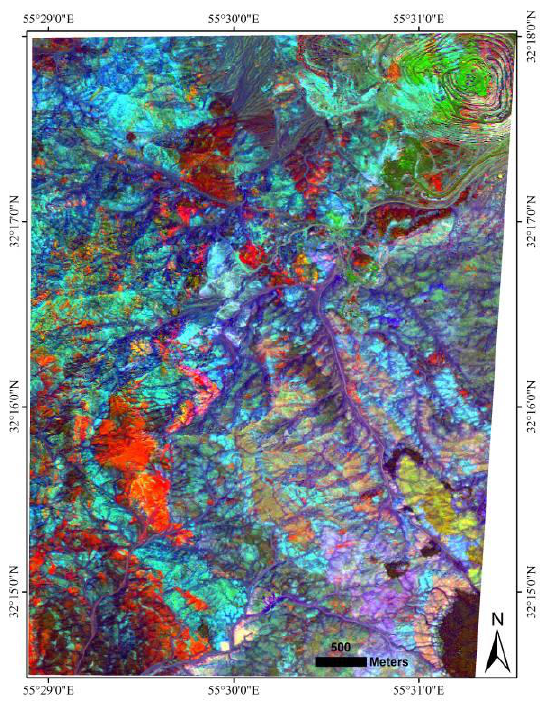
Fig. 6. WV-3 False-color composite 2 m spatial resolution band ratio image of the Chadormalu area, central Iran. sericite-rich rocks (band 13/band 14 = red), ferrous iron-rich rocks (band 13/band 9 = green) and chlorite-epidote rich rocks (band 14/band 16 = blue) are displayed in the image.